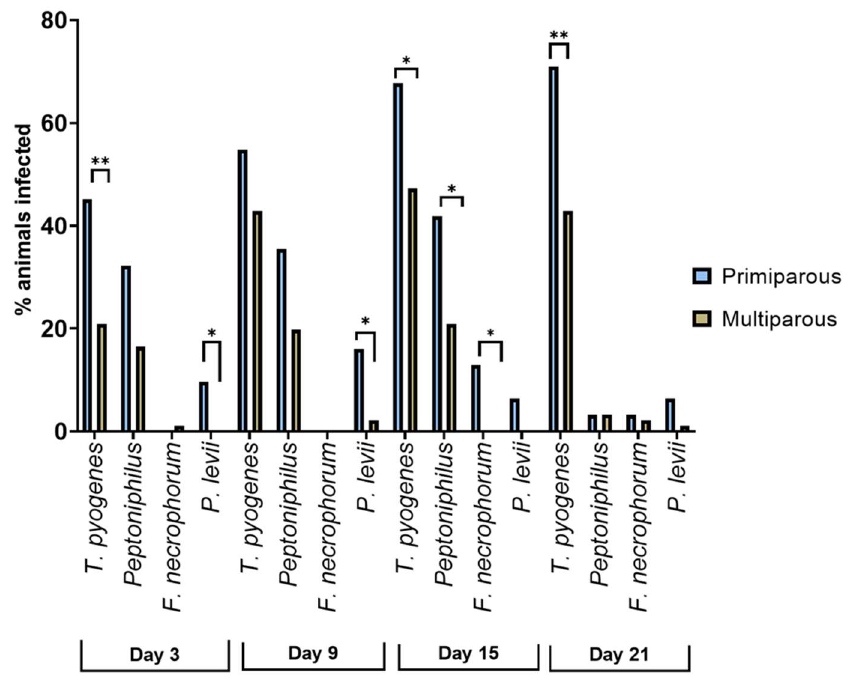
Figure 5. Differences in the prevalence of T. pyogenes , Peptoniphilus spp., F. necrophorum , and P. levii in primiparous ( n = 31) vs. multiparous cows ( n = 91). * indicates 0.01< p < 0.05; ** indicates p < 0.01.